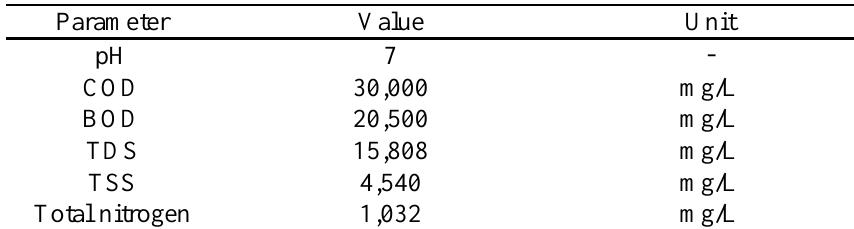
Table 1 . The characteristics of the PME